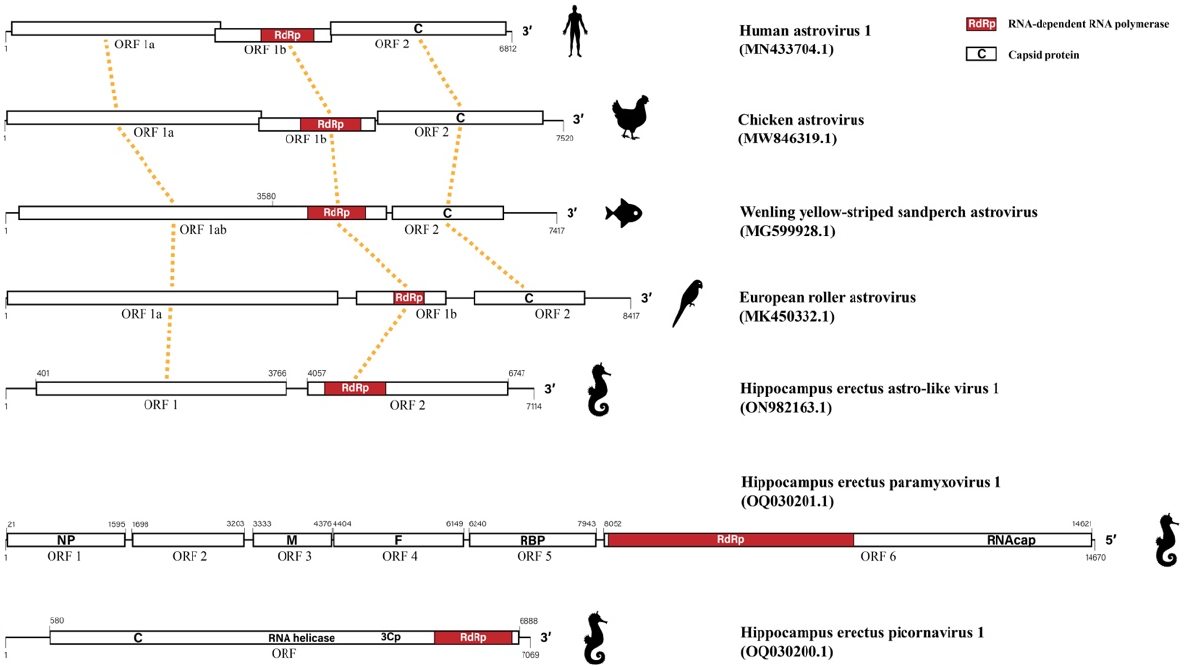
Figure 1. Viral genome structures of the three novel RNA viruses from H. erectus . ( A ) Genome diversity of representative astroviruses and Hippocampus erectus astro-like virus 1 (HeAstV1). The gene regions encoding RNA-dependent RNA polymerase (RdRp) and capsid proteins were highlighted. Homologous regions are connected with orange dotted lines. ( B ) Viral genome structure of Hippocampus erectus paramyxovirus 1 (HePmV1). ( C ) Viral genome structure of Hippocampus erectus picornavirus 1 (HePcV1).